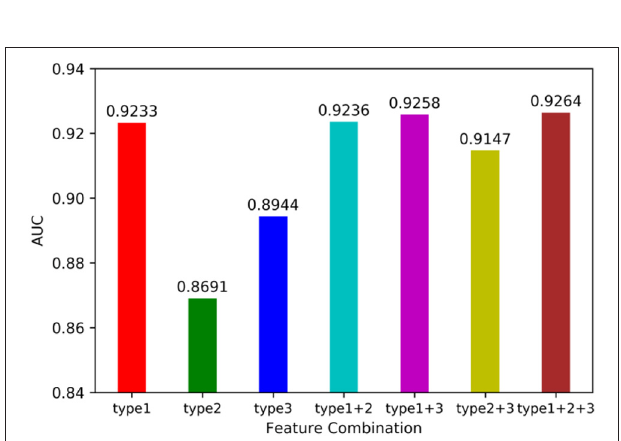
FIGURE 1 | Flowchart of the combinative hypergraph learning to predict the association between miRNAs and diseases.